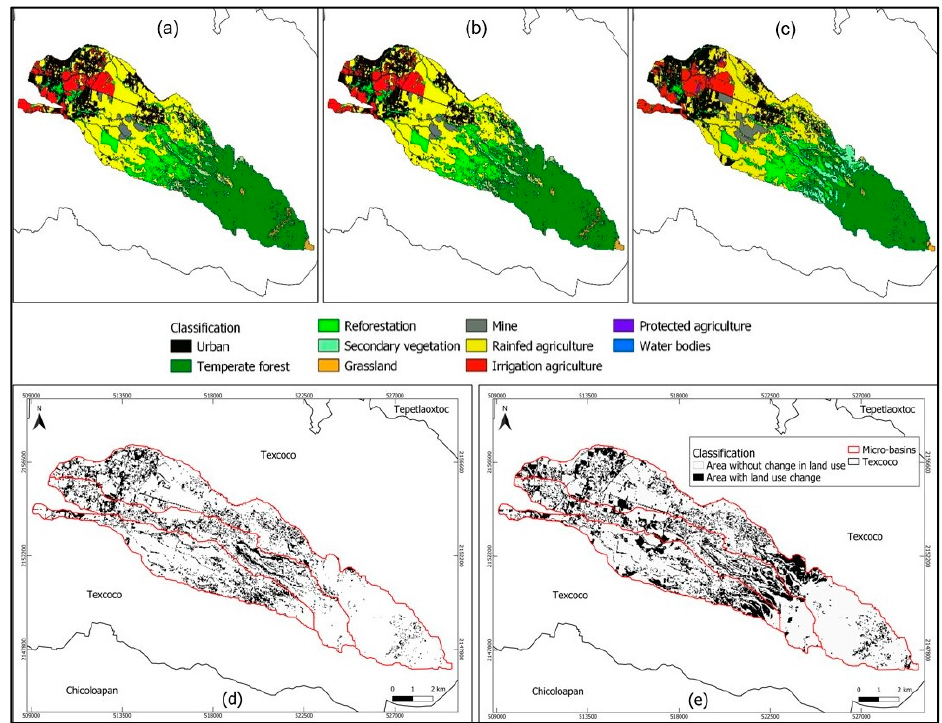
Figure 3. Supervised land use and vegetation classification: ( a ) 1995, ( b ) 2008, and ( c ) 2021. Spatial distribution of the surface with land use changes: ( d ) 1995–2008 and ( e ) 2008–2021.